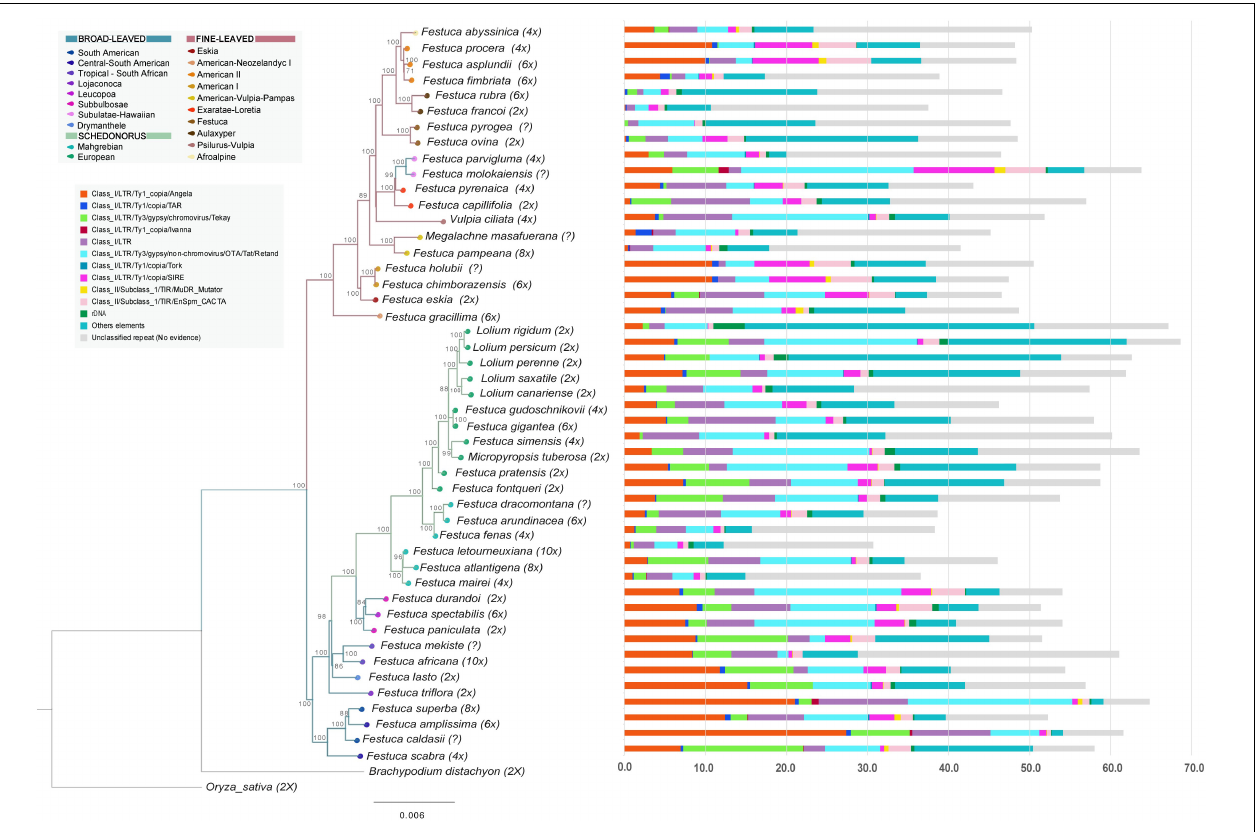
FIGURE 1 | Histograms of repeat contents per holoploid genome (1C) retrieved from the individual Repeat Explorer 2 analyses of the studied Loliinae samples mapped onto the Maximum Likelihood combined phylogenomic tree (plastome + nuclear 35S rDNA cistron) of Loliinae (color codes of Loliinae lineages are indicated in the chart). Color codes for repeat families are indicated in the corresponding inset charts. Scale bar: number of mutations per